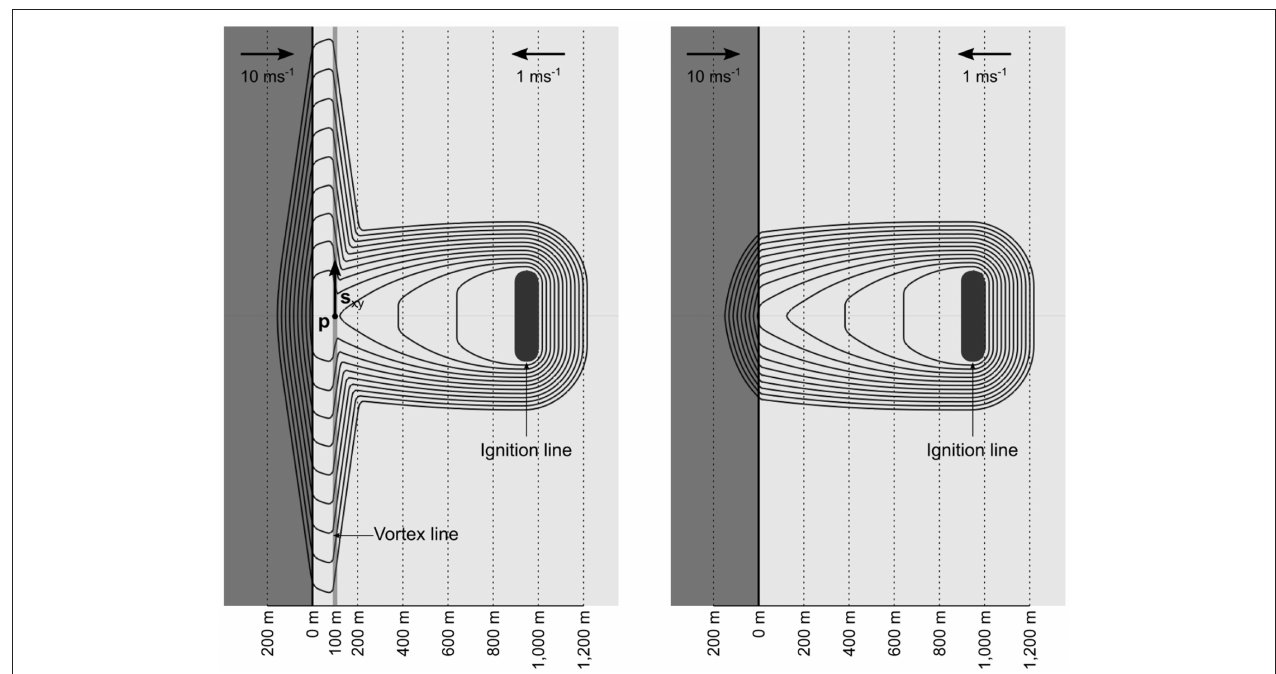
FIGURE 8 | Dynamic calculation in Spark using idealized conditions of B = 0 and C = 0, using the pyrogenic potential model (left) and without (right). The solid lines are fire isochrones at ten minute